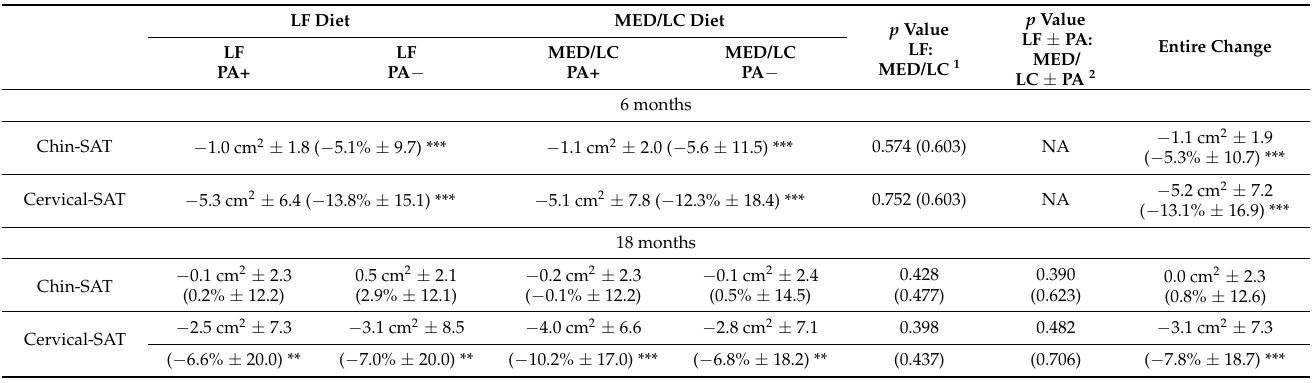
Table 2. 18 months changes in cervical and chin SATs across lifestyle intervention groups.